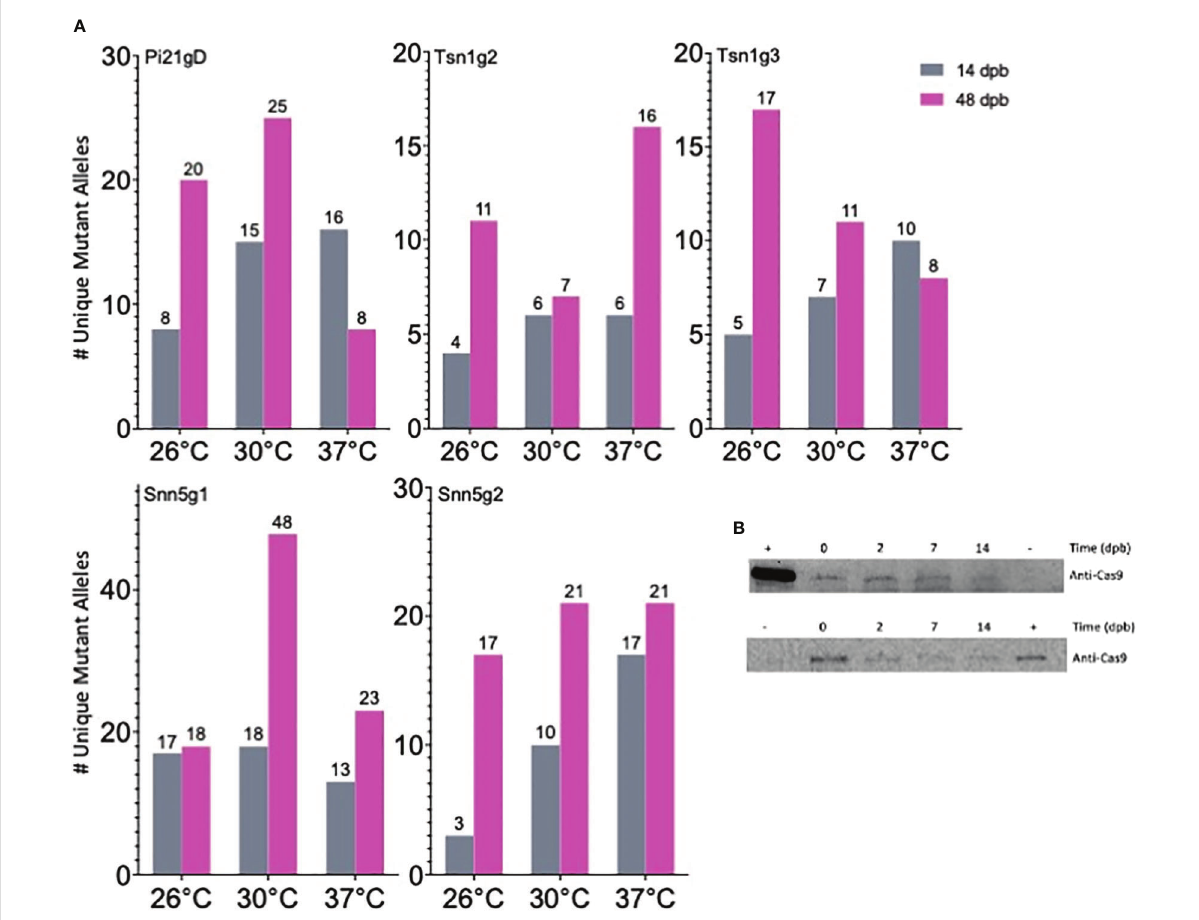
FIGURE 3 Cas9-RNP mediated editing in gold particle bombarded immature embryos IEs is sustained over time. (A) Quanti fi cation of the number of unique mutant alleles detected via deep sequencing. (B) Western blot detection of Cas9 in 10-IE bombarded samples taken 0, 2, 7, and 14 dpb with anti-Cas9 antibody. The top and bottom blot represent 2 independent sets of 10 IEs. + = 9 ng (top) and 3 ng (bottom) Cas9; - = IEs that were not bombarded with Cas9-RNP; loading volume of 25 m l (top) and 40 m l (bottom) total soluble protein extract per IE